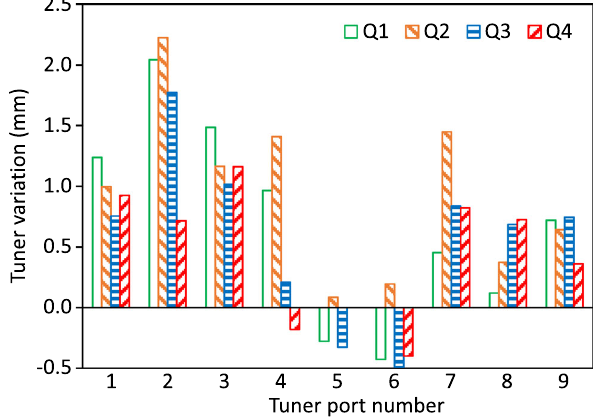
FIG. 14. Tuner insertion depths after low-level tuning. Port number 5 in Q4 is for the input coupler.